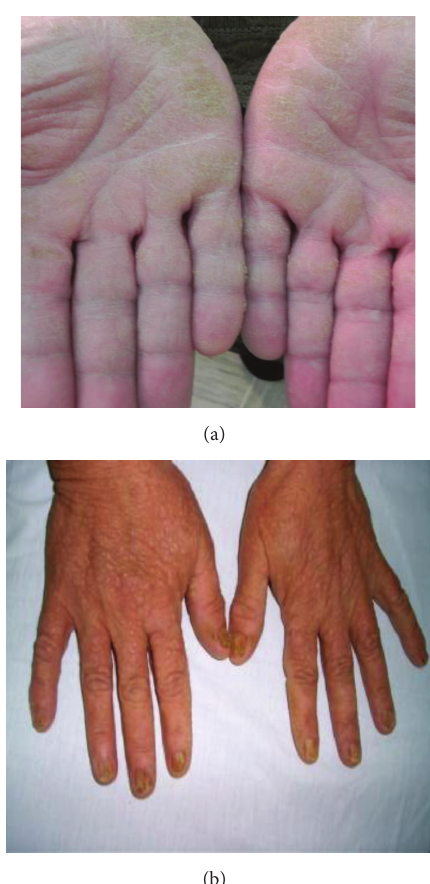
Figure 4: Similar papules were present on the back of her hands and feet. The nails of her hands and feet were also affected (Figures 3 and 4).